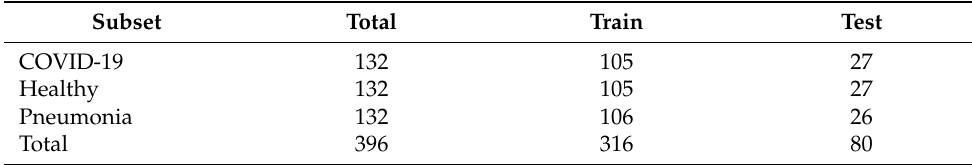
Table 3. Dataset distribution for each subset. Subset Total